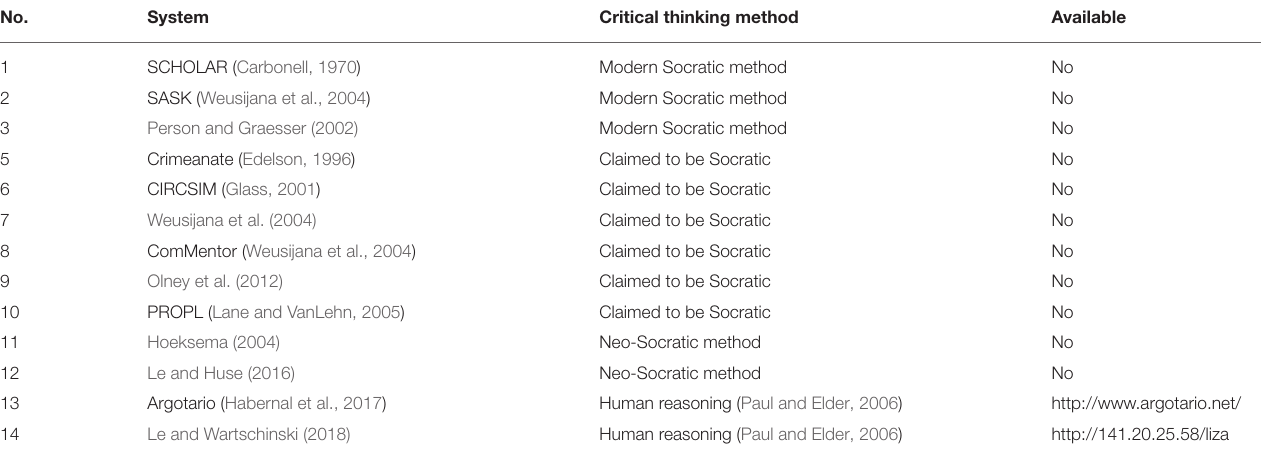
TABLE 3 | A summary of computer-supported educational systems for critical thinking.